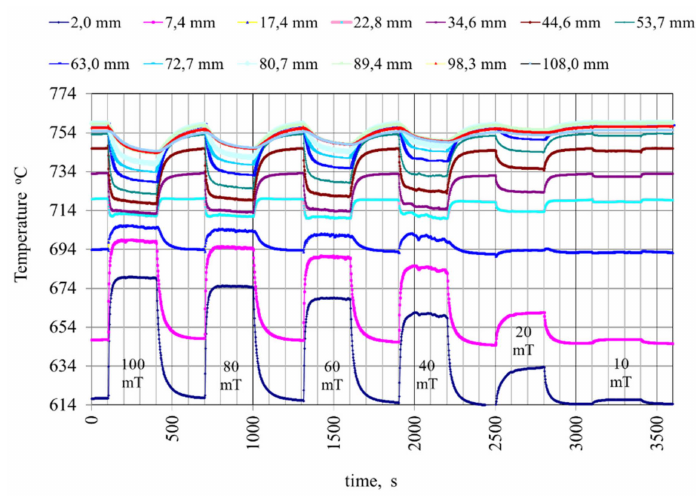
Figure 15. The temperature distribution in the melt at different strengths of magnetic induction over